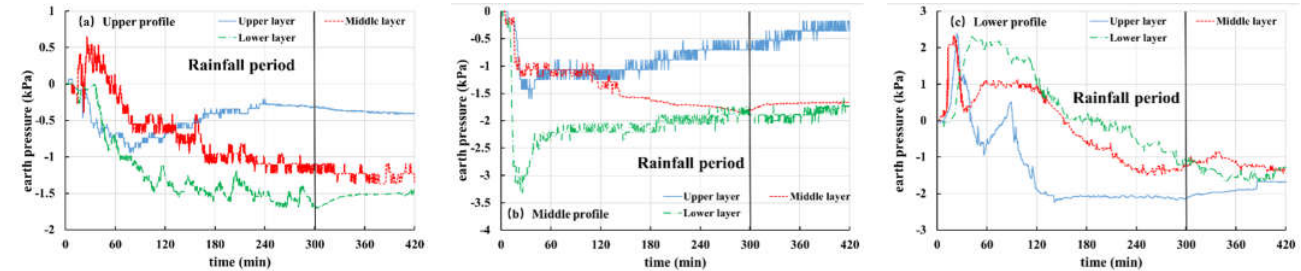
Figure 17. Curves of earth pressure in Test 3 (10 mm, 30 mm/h): ( a ) upper profile; ( b ) middle profile; ( c ) lower profile.